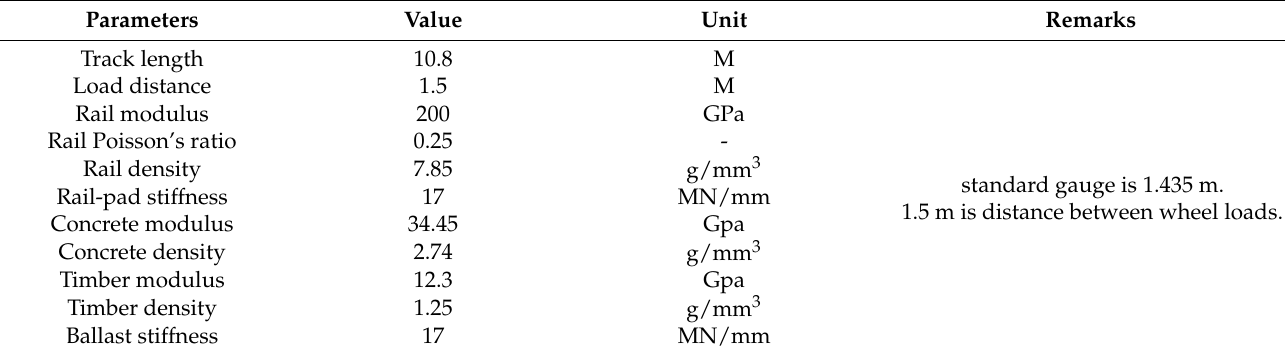
Table 1. Engineering parameters in the